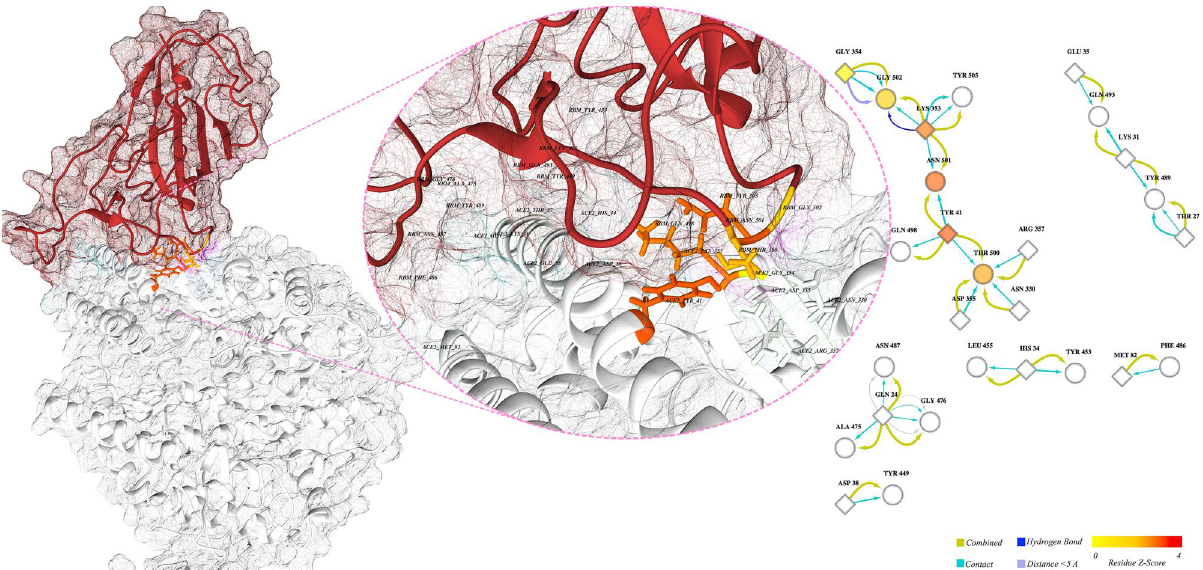
Figure 3. Cartoon representation of RBD in complex with ACE2 and interface residues. The left panel shows the cartoon representation of RBD (brownish ribbons) in complex with ACE2 (white ribbons) based on PDB entry 6VW1 38 . The middle image is a close zoom-in on the interface of the complex; residues involved in the interaction are labeled; surfaces are presented as transparent mesh. The right panel represents the interaction network of interface residues (the amino acids involved in the interaction between RBD and the receptor); ellipses and diamonds are related to RBD and ACE2, respectively. The node colors are based on Z-score (color key at the bottom left), white nodes have negative Z-scores. The colors of the ribbon in the structure are synchronized by the network. The significant Z scores are related to Tyr41 (2.76), Ans501 (2.532), Lys353 (2.26). The Z-score of Thr500, which is one of the corresponding sites, is